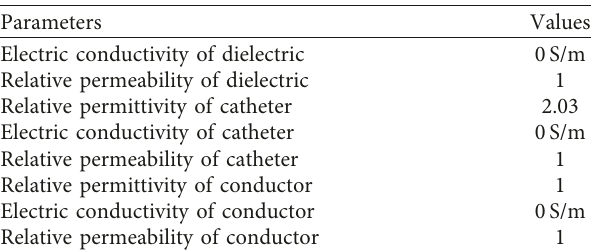
Table 2: Properties of